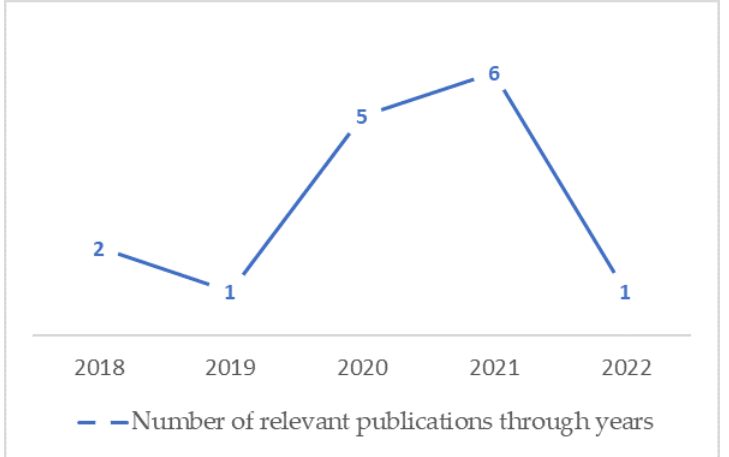
Figure 2. Number of Primary Studies by Year.